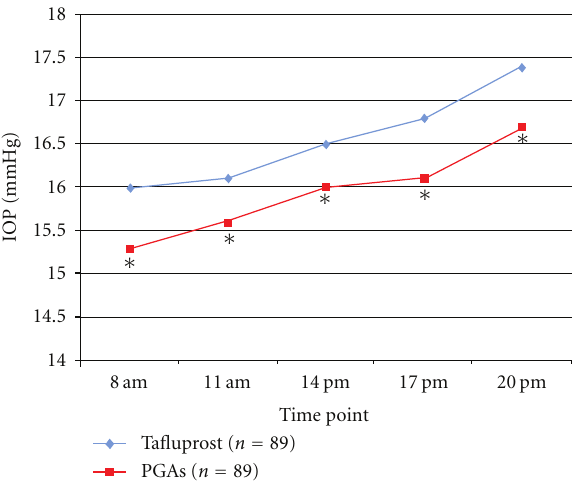
Figure 1: Graph showing IOP at each time point of the daily curve at baseline (PGAs) and after switching to tafluprost. ∗ P > 0 . 05 from the comparison of tafluprost time point with the corresponding PGAs time point. (Curve of PGAs are prestudy, whereas curve of tafluprost is after